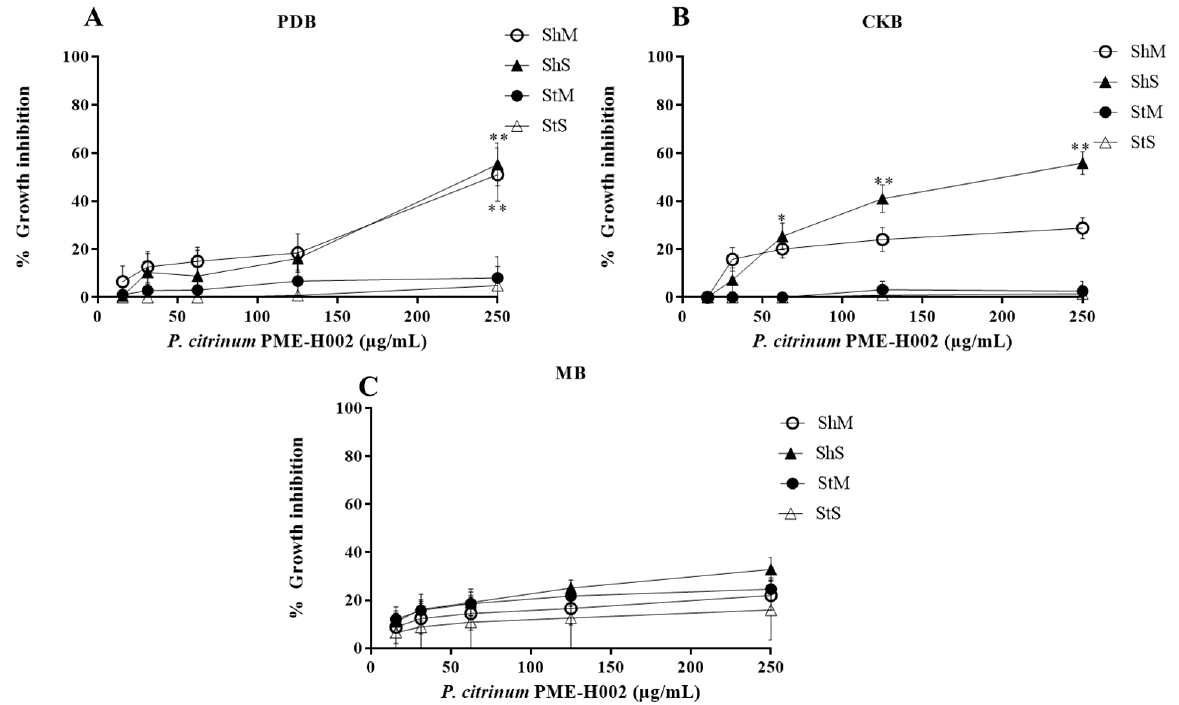
Figure 2. Percentage growth inhibition of P. citrinum PME-H002 strain methanol extracts against L5178Y-R cells in different media and culture conditions. ( A ) PDB, ( B ) CKB, and ( C ) MB. Data rep- resent the mean ± SD of three replicate determinations from three independent experiments. * p < 0.05, ** p < 0.01, as compared with the untreated control using the Kruskal–Wallis test. Sh, shaking; St, static; M, mycelium; S, spore.